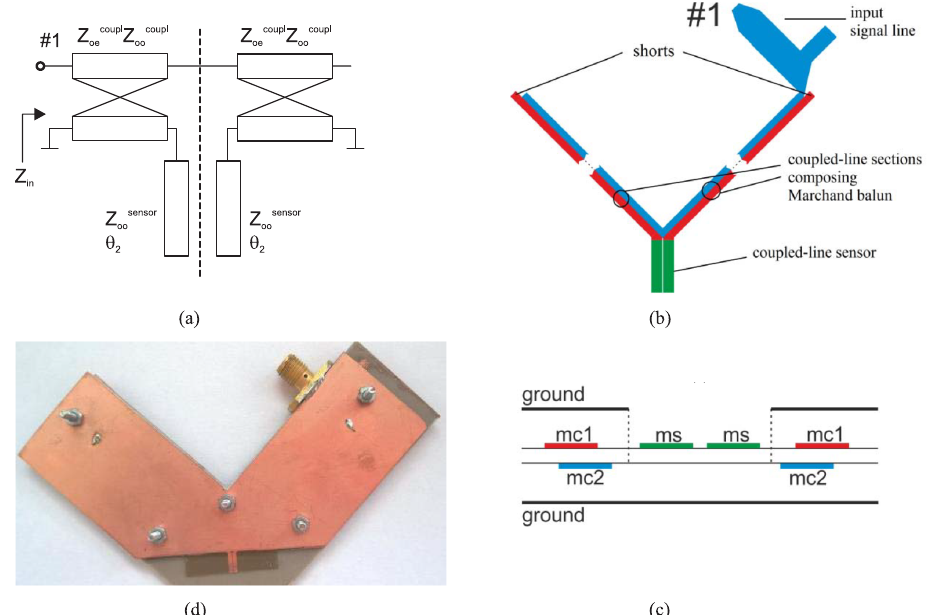
Figure 33. The measurement setup composed of a Marchand balun and an open-ended coupled-line sensor: ( a ) schematic and ( b ) layout and ( c ) cross-sectional views and ( d ) fabricated setup. Reprinted with permission from Ref. [40].